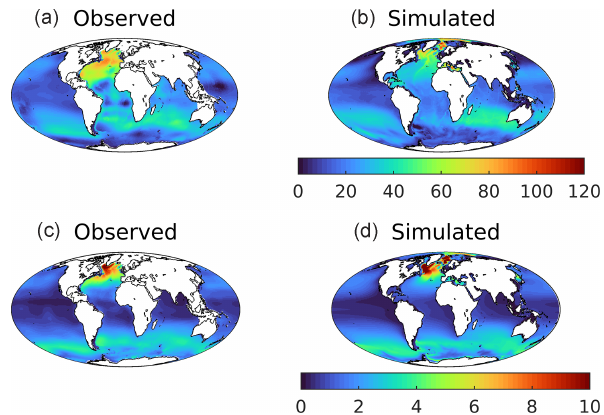
Figure 18. Observed ( a, c ; Key et al., 2004) and modelled (b, d) ver- tically integrated anthropogenic CO 2 ( a, b ; molCm − 2 ) and CFC- 11 ( c, d ; µmolm − 2 ) in the 1990s. GLODAPv1.1 is used here as the time period used overlaps that of observational